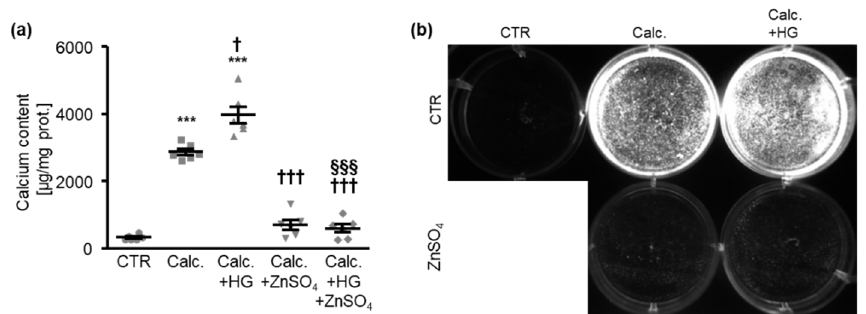
Figure 1. Zinc sulfate inhibits the calcification of HAoSMCs promoted by high levels of glucose. ( a ). Calcium content ( n = 6, µg/mg protein) in HAoSMCs treated for 11 days with control (CTR) or calcification medium (Calc.) without and with high glucose levels (HG) in the absence and presence of ZnSO 4 . *** ( p < 0.001) significant difference versus control group; † ( p < 0.05), ††† ( p < 0.001) significant difference versus Calc.-treated group; §§§ ( p < 0.001) significant difference between Calc.+HG- and Calc.+HG+ZnSO 4 -treated groups. ( b ). Calcification detected by fluorescence imaging in HAoSMCs treated for 11 days with control (CTR) or calcification medium (Calc.) without and with high glucose levels (HG) in the absence and presence of ZnSO 4 . Calcified areas: white pseudocolor. These effects were paralleled by the inhibition of osteo-/chondrogenic signaling in HAoSMCs, as indicated by osteo-/chondrogenic marker expression and activity. High lev- els of glucose induced CBFA1 , SOX9 , and ALPL mRNA expression in HAoSMCs, effects